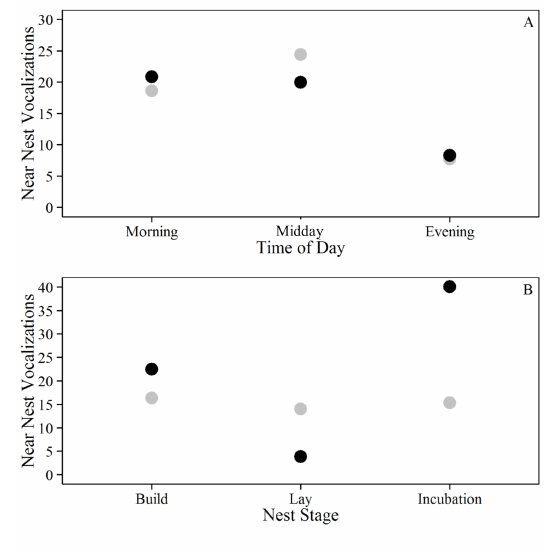
Table 3. Comparison of a priori selected models to assess the predator-attraction hypothesis and the relationship between vocalization rate by male vireos and nest stage (Stage), time of day (Time), and depredation fate (Depr). Models are compared using AIC (Akaike 1974) and model weights (wi) c Parameters ∆AIC Stage + Time + Depr + Stage*Time + Stage*Depr + Time*Depr